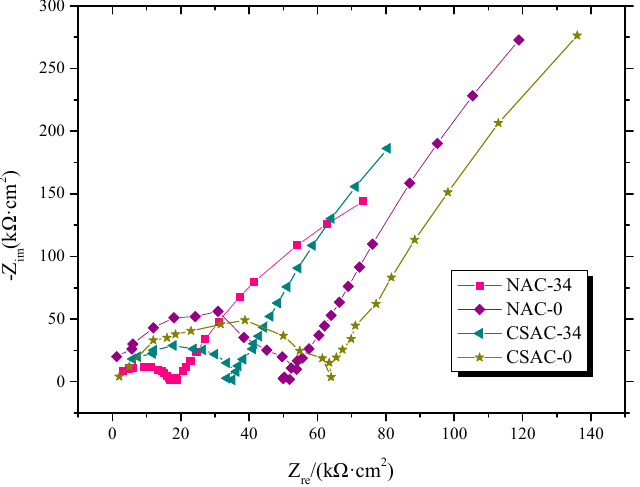
Figure 6. Nyquist curve comparison of rebar in NAC and CSAC.